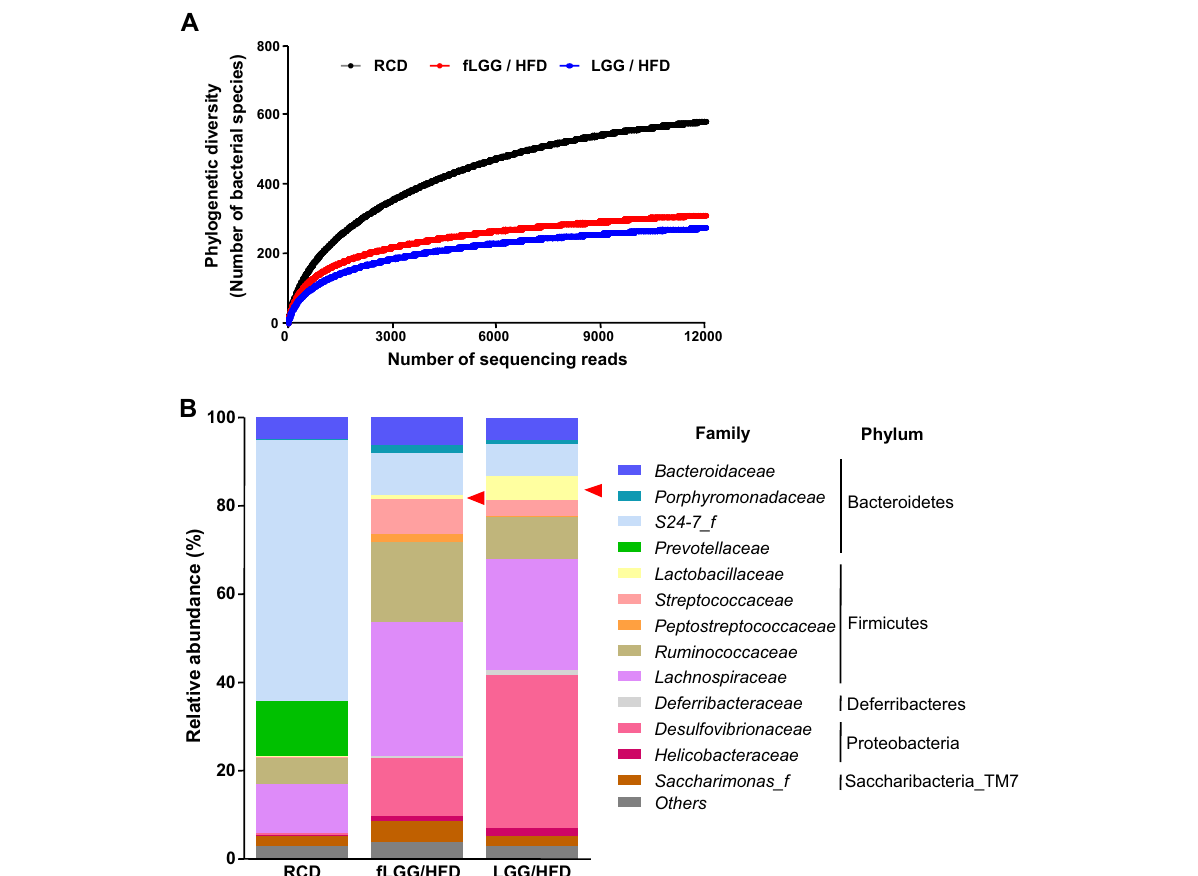
Fig. 6 The effect of L. rhamnosus GG on the gut microbiota during short-term HFD feeding. a Rarefaction curves plotted for phylogenetic distance between the microbiota of the RCD, fLGG, and LGG groups. Phylogenetic distance was calculated at a rarefaction depth of 12,000 sequences/sample. b Comparison of family-level proportional abundance in the feces of the RCD, fLGG, and LGG groups (pooling, n = 3 per group). The red arrow indicates